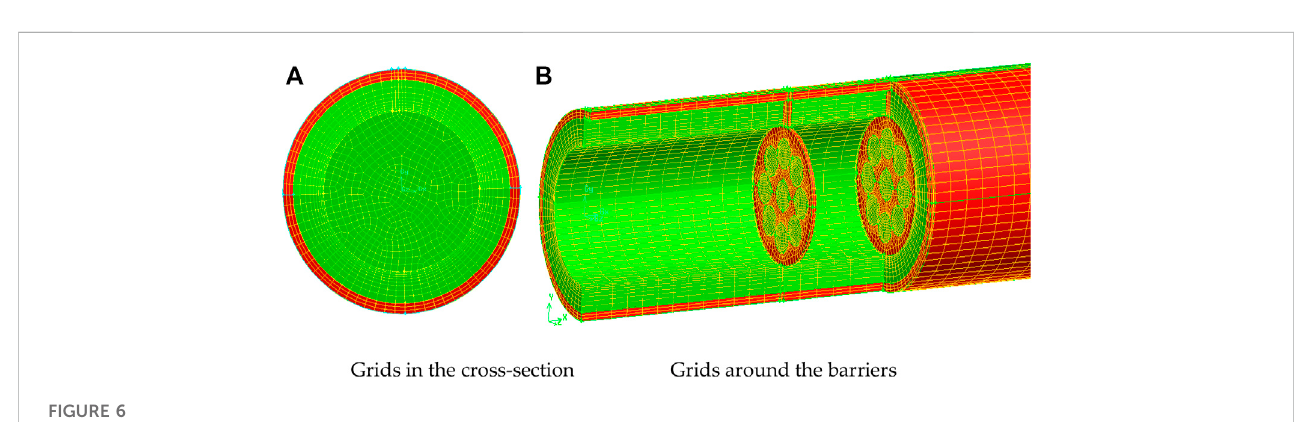
FIGURE 6 3D mesh of the computational